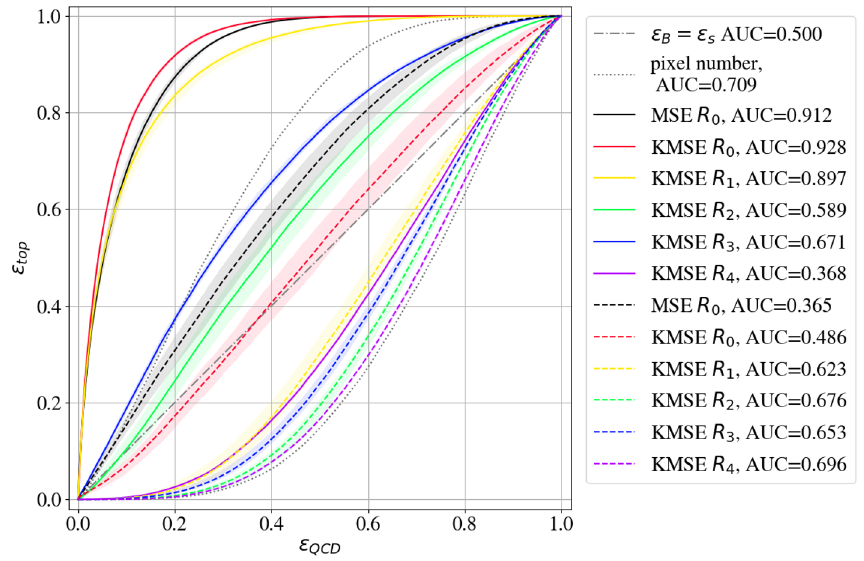
Figure 16 . ROC curves of the direct (solid) and inverse (dashed) taggers using the different intensity mappings R 0 to R 4 for the KMSE and R 0 for the MSE loss function. The dotted lines represent the ROC curves of the two taggers based on the number of the non-zero pixels in the